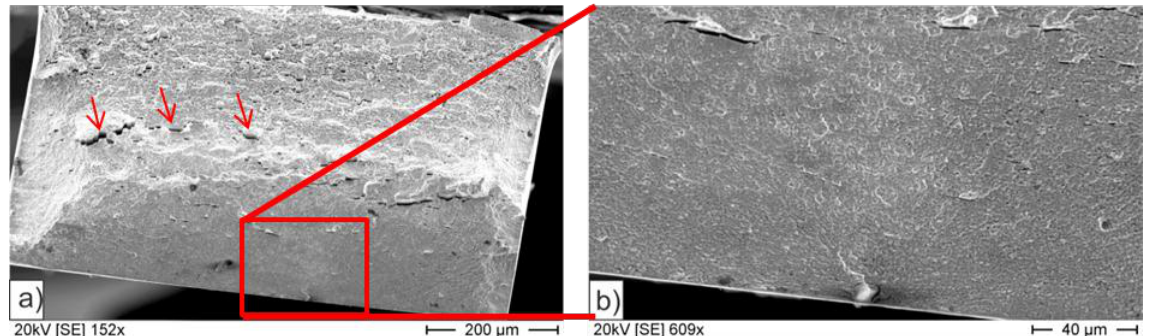
Figure 7. Fracture surface of s-HPT-10 ( a ) whole fracture surface ( b ) fatigue fracture surface; some shear bands resulting from HPT are shown with